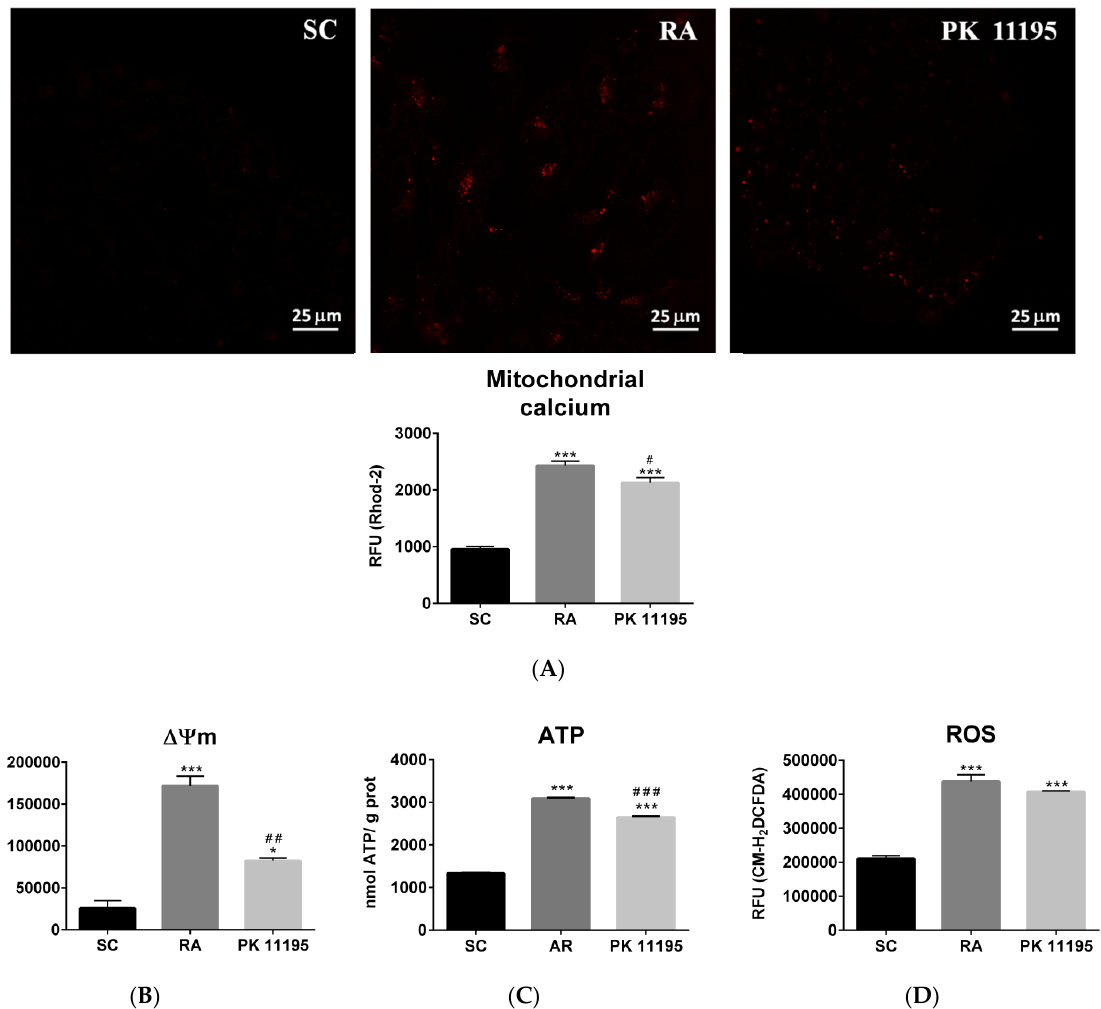
Figure 6. Mitochondrial parameters in undifferentiated P19 stem cells (SC) and cells treated with 1 μ M retinoid acid (RA) or 50 μ M PK 11195 (PK 11195) during 4 days of treatment. ( A ) Mitochondrial Ca 2+ was assayed by fluorescence of Rhod ‐ 2 and representative micrographs of Rhod ‐ 2 fluorescence are shown for each one of the experimental conditions (SC, RA, and PK 11195). Bar chart shows quantification of the mitochondrial Ca 2+ represented as means ± SEM from three independent cell cultures and treatments. Scale bar at the bottom right, 25 μ M. ( B ) The mitochondrial membrane potential ( ∆Ψ m) was analyzed by fluorescence of TMRM. Bar chart shows means ± SEM of the ∆Ψ m from three independent cell cultures and treatments. ( C ) The ATP content was evaluated by bioluminescence. Bar chart shows the quantification of the intracellular ATP levels (nmol/g protein) represented as means ± SEM from three independent cell cultures and treatments. ( D ) Reactive oxygen species (ROS) levels were analyzed by fluorescence of CM ‐ H 2 DCFDA. Bar chart shows the quantification of the intracellular ROS levels represented as means ± SEM from three independent cell cultures and treat ‐ ments. * p < 0.05 versus SC; *** p < 0.001 versus SC; # p < 0.05 versus RA; ## p < 0.01 versus RA; ### p < 0.001 versus RA. RFU, Relative units of fluorescence.